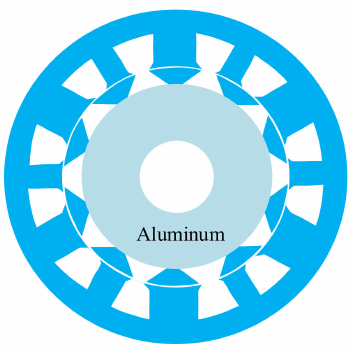
Figure 6. One-stack segmental